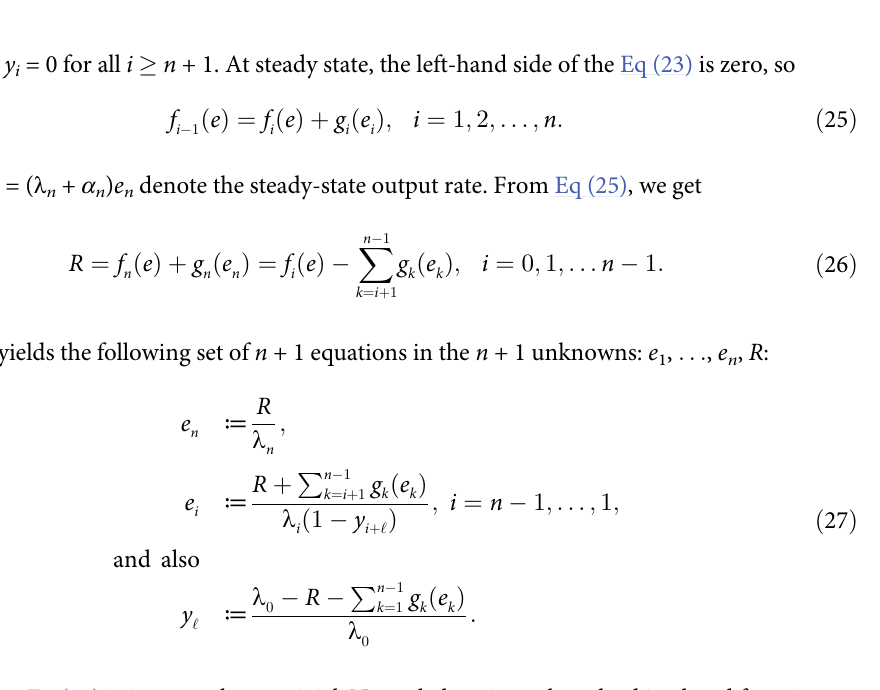
Fig 12. The steady-state output rate R as a function of E for a EFEIOD with n = 3, ℓ = 2, λ 0 = 1, λ all i and r = 1/ q .